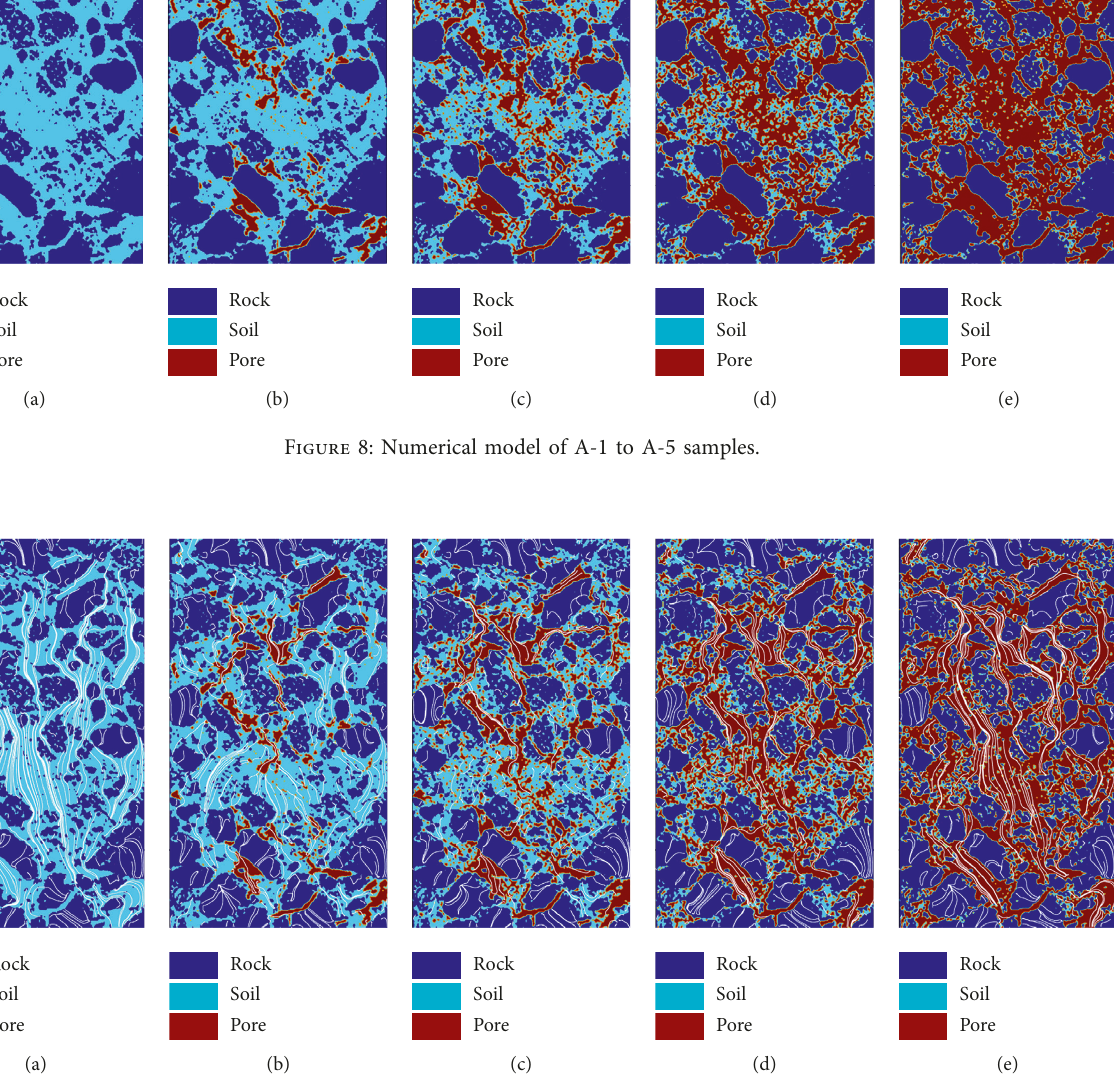
Figure 9: Seepage simulation results of A-1 to A-5